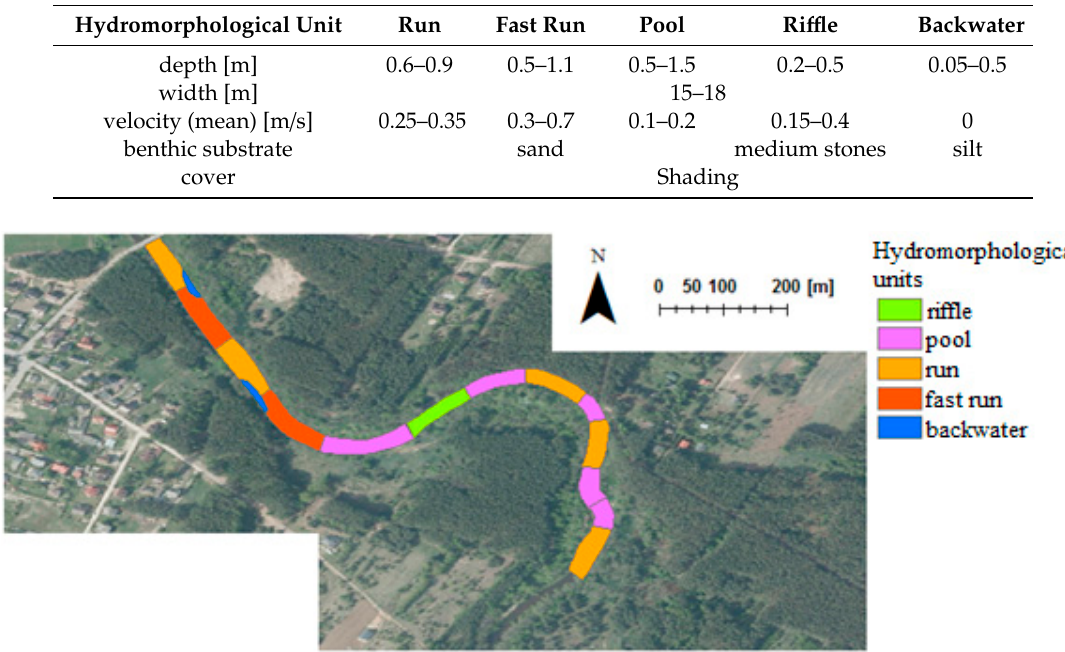
Table 3. Assumed parameter ranges for the simulated river restoration of the Swider River.